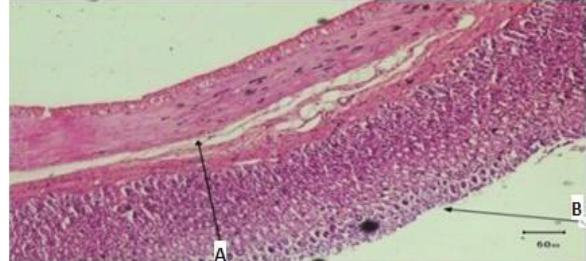
Fig-5: H &E stained slide of fluvoxamine pretreated group showing following